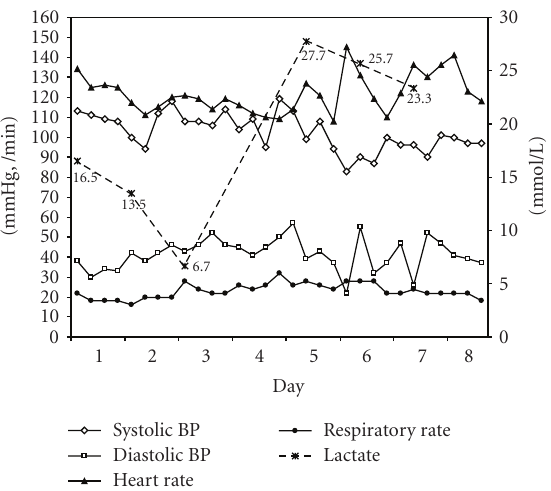
Figure 2: Correlation between lactate level and vital signs.